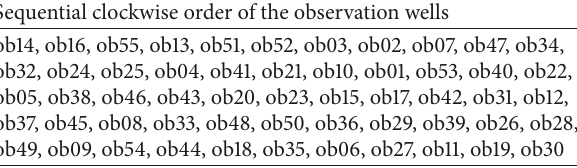
Table 2: Sequential clockwise order of the observation wells used for the inverse model. Sequential clockwise order of the observation wells ob14, ob16, ob55, ob13, ob51, ob52, ob03, ob02, ob07, ob47, ob34, ob32, ob24, ob25, ob04, ob41, ob21, ob10, ob01, ob53, ob40, ob22, ob05, ob38, ob46, ob43, ob20, ob23, ob15, ob17, ob42, ob31, ob12, ob37, ob45, ob08, ob33, ob48, ob50, ob36, ob29, ob39, ob26, ob28, ob49, ob09, ob54, ob44, ob18, ob35, ob06, ob27, ob11, ob19,